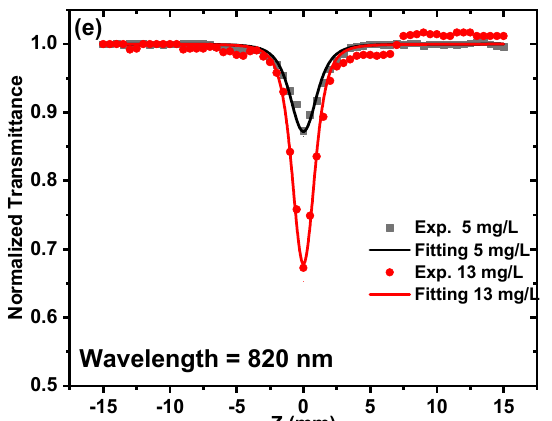
Figure 8. OA Z-scan measurements for the ZnONPs colloids at different excitation wavelengths ranging from 740 to 820 nm at a constant peak intensity of 15.8 GW/cm 2 ( a – e ). The dots indicate the experimental results, and the solid lines indicate the theoretical fitting.